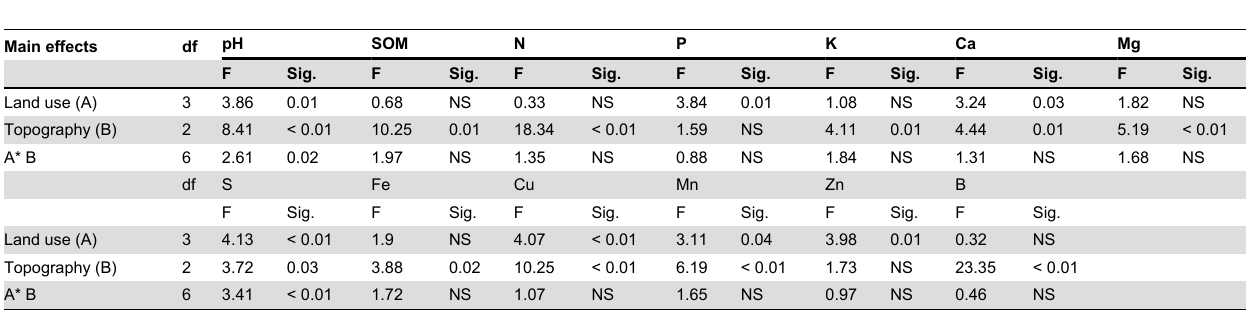
Table 4. Summary statistics of a two-way ANOVA looking at the effects of land use and topography types on surface soil properties.